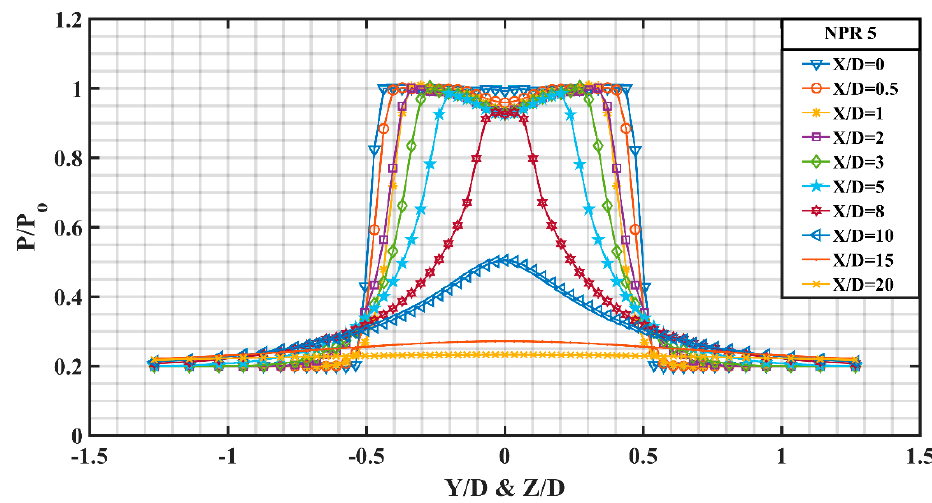
Figure 18. Pressure profile variation for uncontrolled jet at NPR 5.